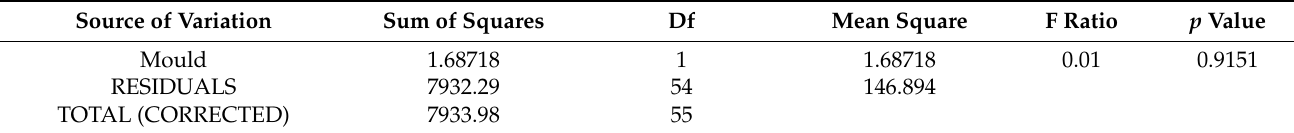
Table 15. ANOVA for PLA flexural strength (annealing temperature range 63–155 ◦